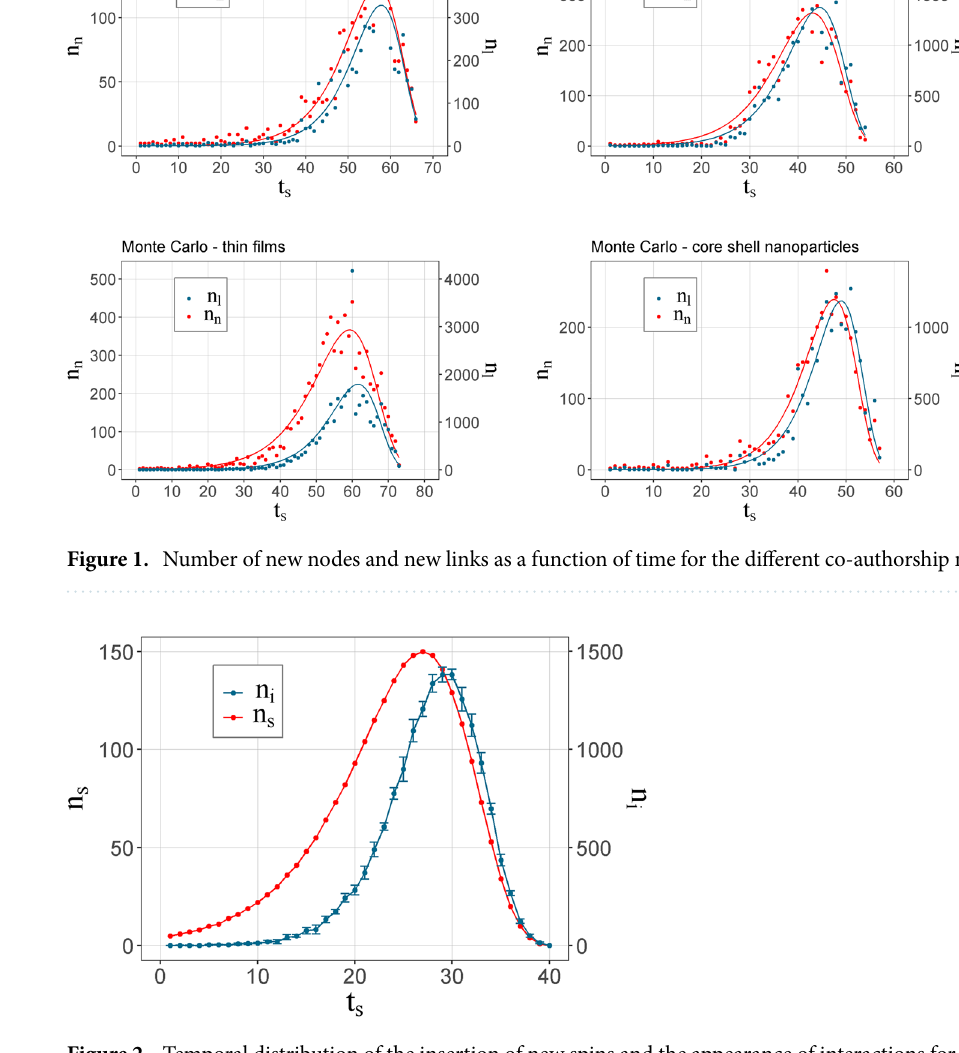
Figure 2. Temporal distribution of the insertion of new spins and the appearance of interactions for simulations with t p = 27 in Monte Carlo